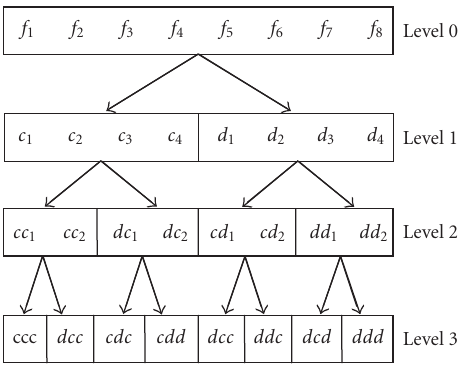
Figure 2: Wavelet packet decomposition tree.